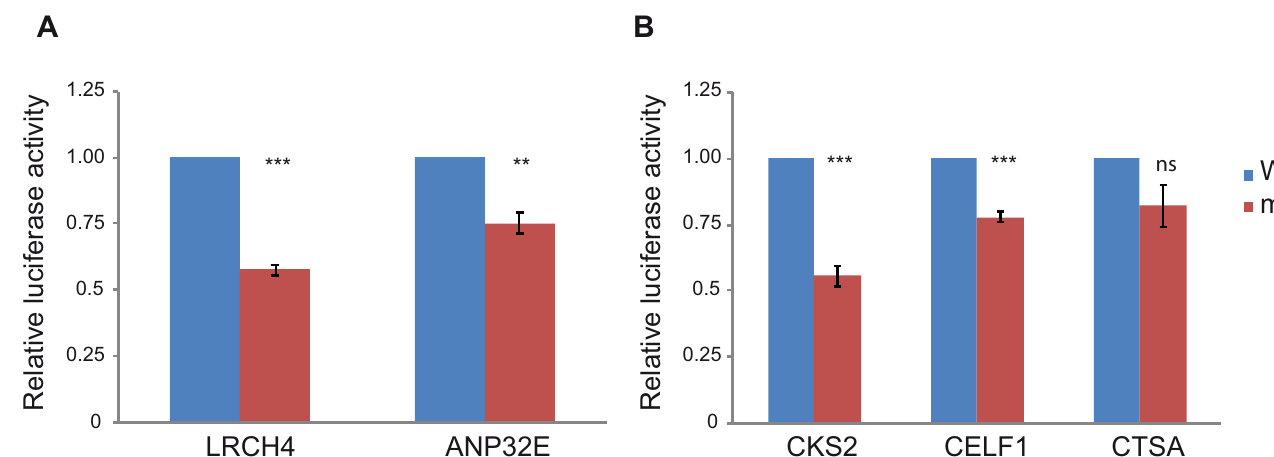
focused than LRCH4, ANP32E, CKS2 and CELF1 (S6 Fig). Taken together, using the